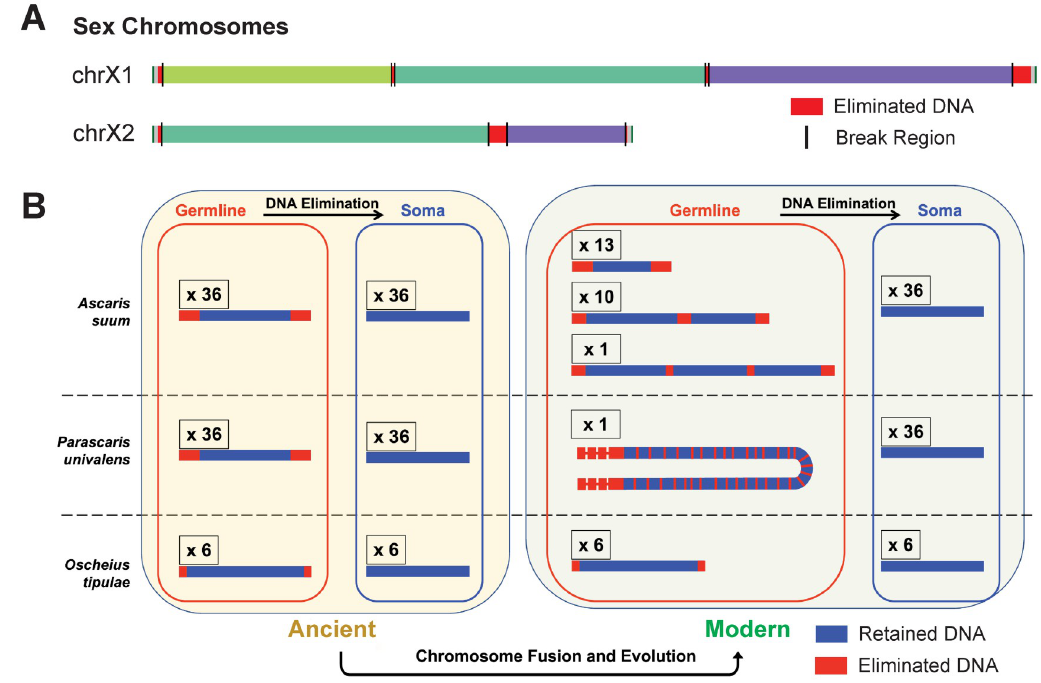
Fig 4. An evolution model of PDE in nematode chromosomes. ( A ) Fusions in Ascaris sex chromosomes. Two representative sex chromosomes with distinct ancestral regions (Nigon elements; each Nigon group is shown in a different color). Eliminated DNA is at the junction of different Nigon elements. ( B ) Fusion and evolution of chromosomes in nematodes with PDE. Left: hypothetical ancient chromosome karyotypes before and after chromosome end remodeling and DNA elimination in Ascaris , P . univalens , and O . tipulae . Right: modern karyotypes before and after DNA elimination showing internal breaks and end- remodeling. For simplicity, a representative chromosome is shown for all chromosomes within a group that have the same pattern of elimination (terminal and/or internal). The number of chromosomes for each group is indicated above the representative chromosome. ( A ) and ( B ) are adapted from [45].